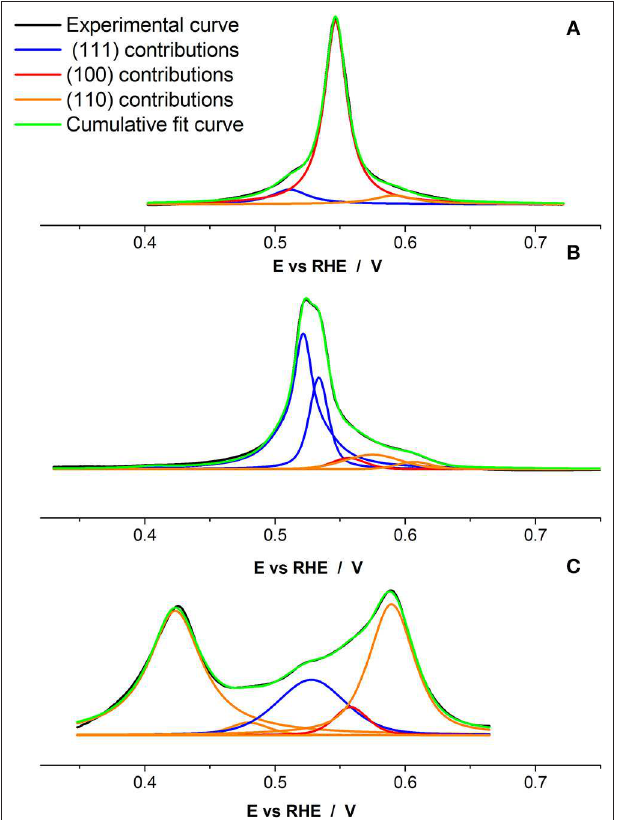
FIGURE 5 | Cu UPD voltammograms obtained with (A) Pd Cub , (B) Pd Oct , and (C) Pd RD nanoparticles. Test solution 0.1M H 2 SO 4 + 1mM Cu 2 + + 1mM NaCl, scan rate 50mV s − 1 .